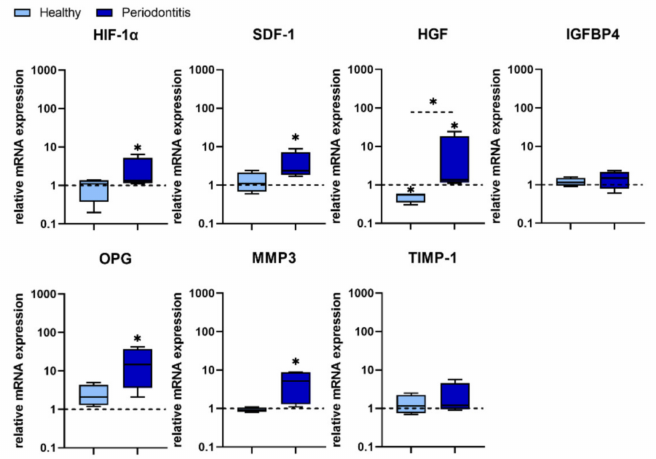
Figure 7. Expression of genes associated with tissue regeneration/repair in GMSCs treated with P. gingi- valis. The basic level of each mRNA expression is counted as 1 (non-treated GMSCs) and is marked with a dotted line. The asterix above the boxes indicates the significant difference between non-treated and P. gingivalis treated H- or P-GMSC lines (* p < 0.05). The asterix above the line indicates the significant difference between H- and P-GMSCs treated with P. gingivalis (* p < 0.05); n = 4 in each